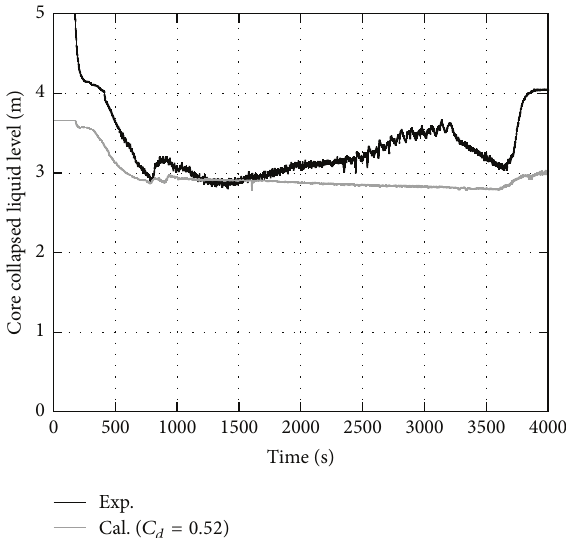
Figure 14: LSTF and RELAP5 results for core collapsed liquid level in case of release of dissolved gas.